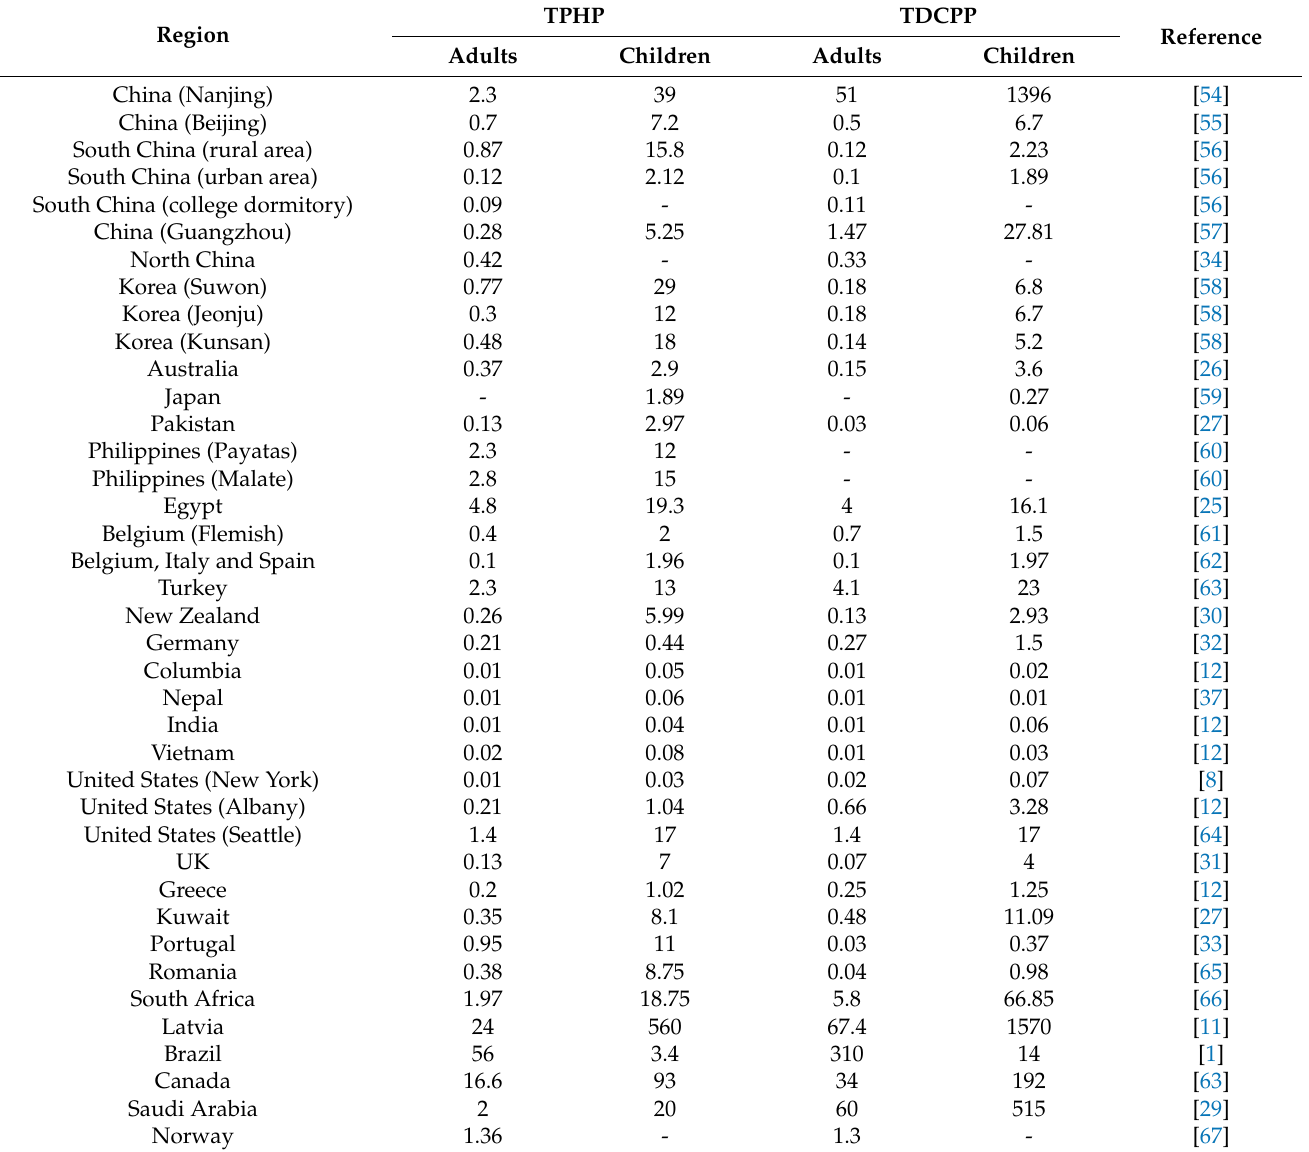
Table 2. EDIs (ng/kg-bw/day) of TPHP and TDCPP via dust ingestion for children and adults from different